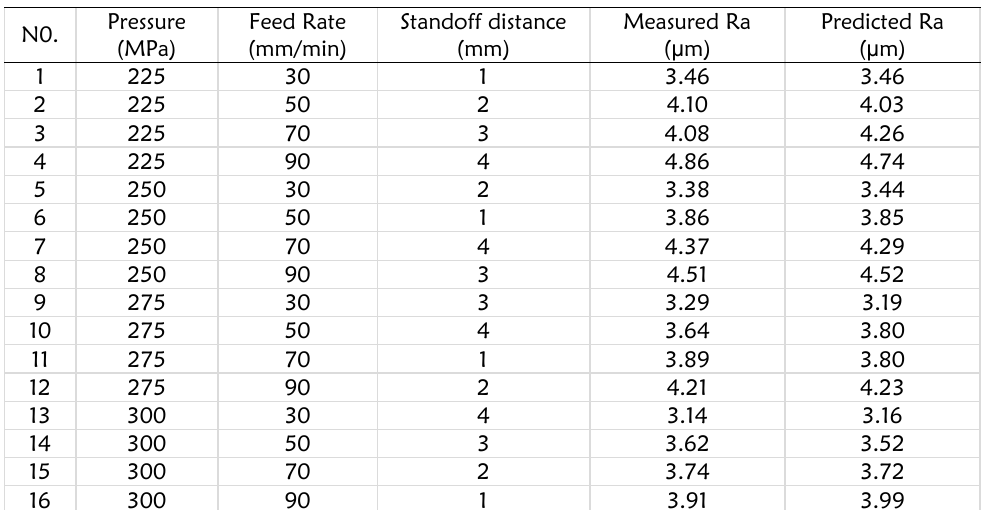
Table 6: Measured and predicted surface